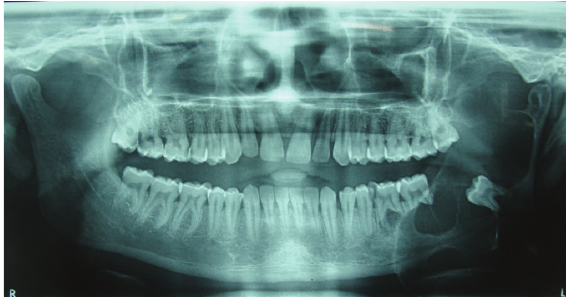
Figure 2: OPG showing multilocular radiolucency in relation to left third molar involving the angle, ramus, and coronoid process of the mandible. Root resorption is evident in mandibular I, II, and III